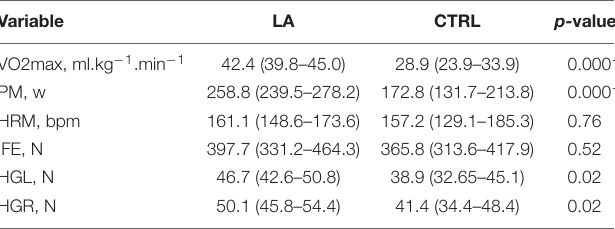
TABLE 2 | Cardiorespiratory fitness, isometric strength, and handgrip force of lifelong endurance athletes (LA, n = 13) and control group (CTRLs, n = 9). Variable